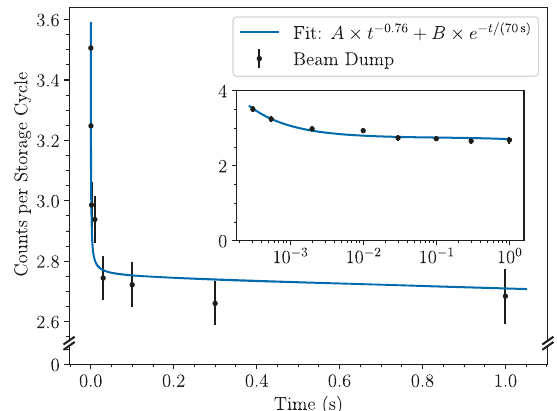
Fig. 5 Averaged numbers of C 23 H þ x fragments remaining in the storage ring determined by dumping the beams after different times. This was achieved by switching the de fl ector at the end of a straight section to 0 V and counting the ions that then struck the detector. Each data point is the result of 500 storage and dump cycles. The solid blue curve shows the least square fi t of Eq. (2). The same data with a logarithmic horizontal axis is shown in the inset. The error bars represent the 1 σ statistical uncertainties of each data point. Source data are provided as a Source Data fi